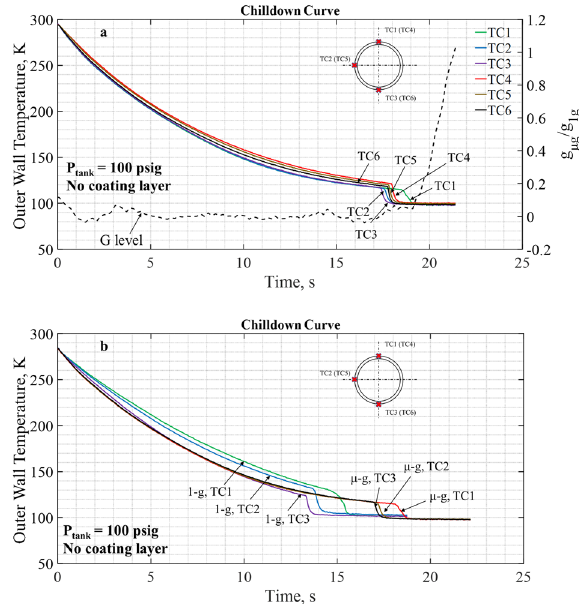
Fig. 3 Quality of microgravity environment in parabolic fl ights. a Three chilldown curves are plotted using the temperature data registered by the three thermal couples depicted in Fig. 7d where TCs 1 (top), 2 (side), and 3 (bottom) are all located at the same axial location (upstream TC station). Three additional chilldown curves from the three TCs 4 (top), 5 (side), and 6 (bottom) placed at the downstream location are also plotted for comparison. The chilldown curves provide the tube wall outer surface temperature histories during chilldown. The z -acceleration (upward in the aircraft coordinate system) is also plotted versus time in this fi gure. The acceleration levels or g-jitters of the microgravity period are within ±0.01 g and all other fl ights had the same acceleration levels. b The three microgravity chilldown curves from Fig. 3a are plotted together with their terrestrial (1 − g ) counterparts (horizontal tube test chilldown curves 28 ).